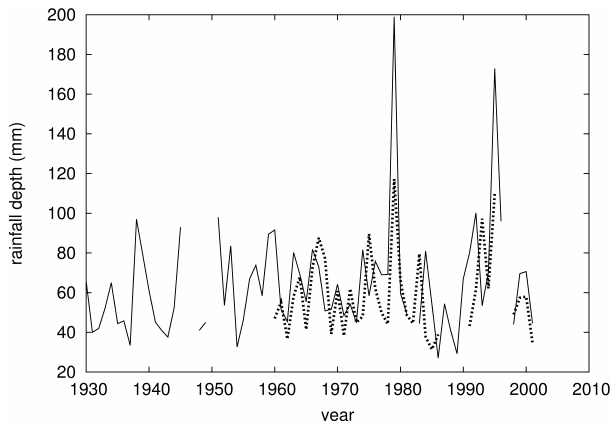
Fig. 3. Depth-Duration-Frequency curves for return periods T = 100 yr (thick lines) and T = 20 yr (thin lines) for the stations: CRE- MONA (solid lines) and LODI (dotted lines). The assumed distri- bution is GEV and its parameters have been estimated by the L- moments method, separately on each